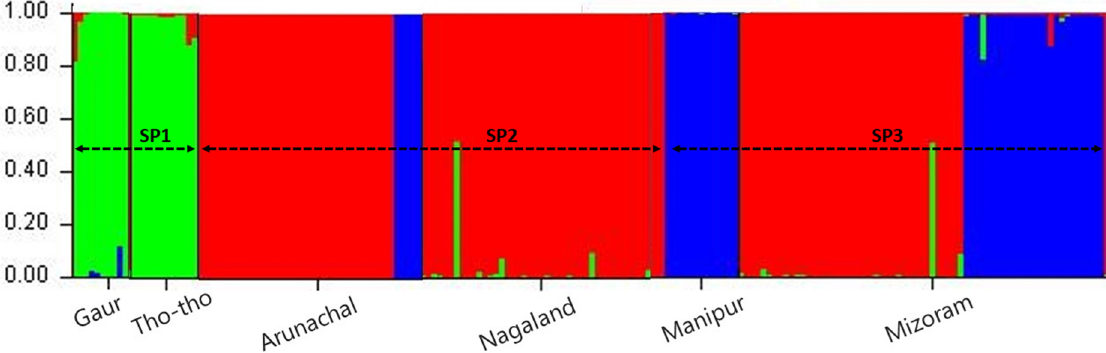
Figure 2. Model ‐ based grouping utilizing the STRUCTURE analysis clustered all the bovine popu ‐ lations into three subgroups (SP1, SP2, and SP3) . SP1 = Gaur and Tho ‐ tho samples; SP2 = Arunchal and Nagaland mithun samples; SP3 = Manipur and Mizoram mithun samples given different color codes, assuming K = 3.